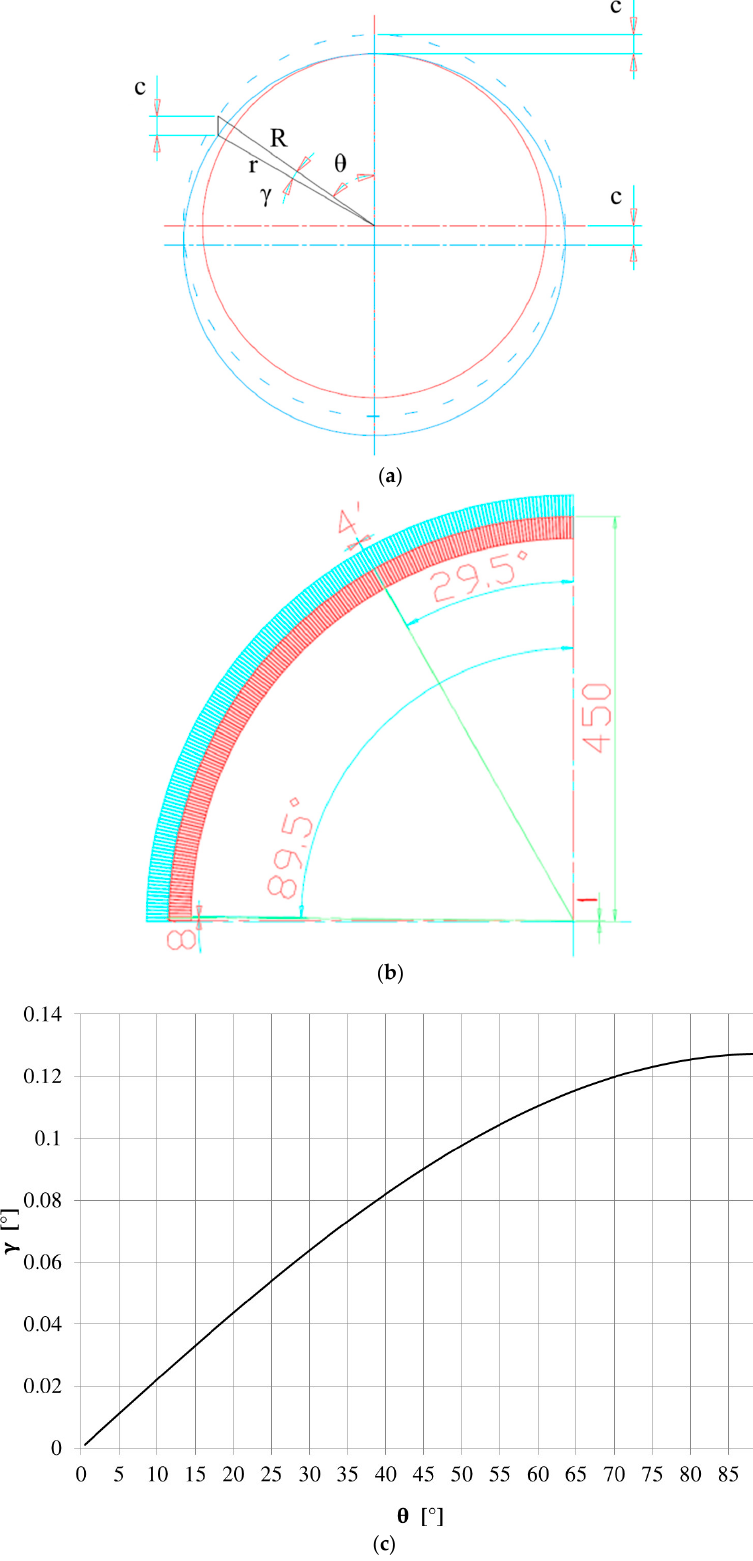
Figure 9. ( a ) Sketch for the evaluation of the misalignment angle γ ; ( b ) practical example via CAD system and ( c ) related trend of γ as a function of θ .